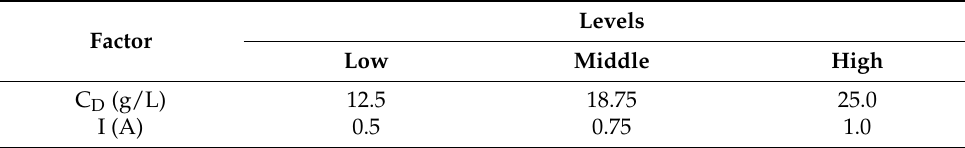
Table 1. Factors and